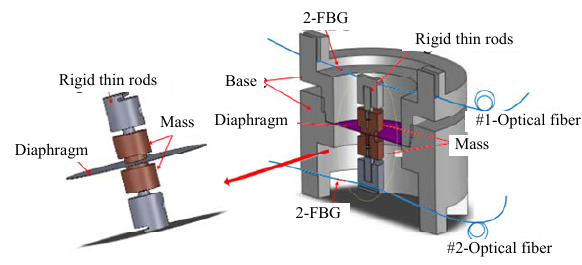
Fig. 18 Structure of the designed vibration sensor.